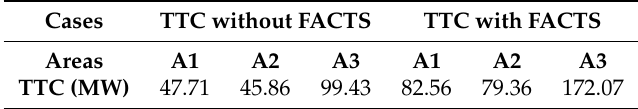
Table 8. TTC values of overall system for IEEE 39 bus